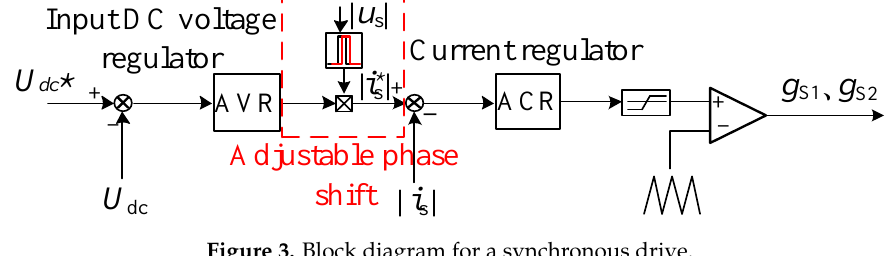
Figure 3. Block diagram for a synchronous drive.